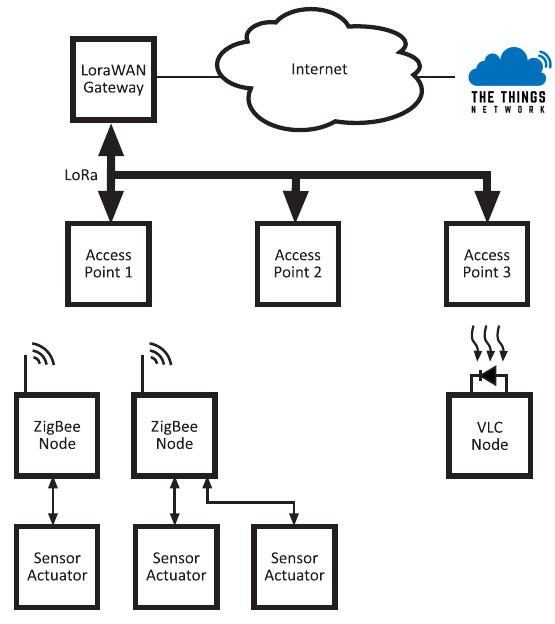
Figure 2. Global network